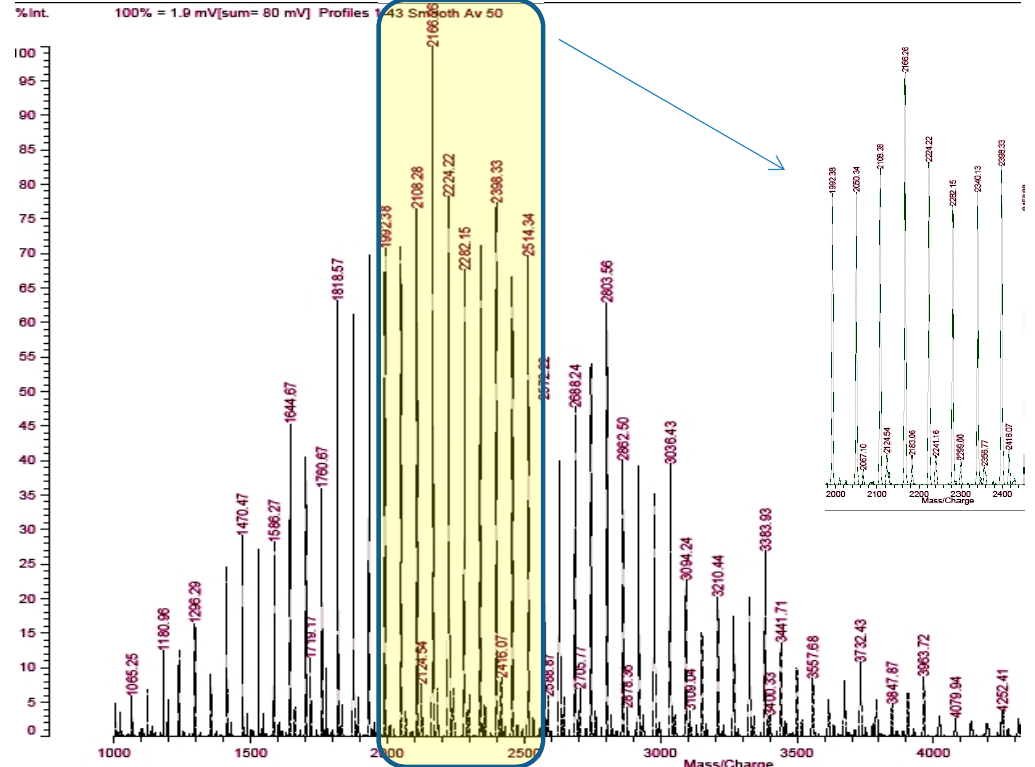
Figure 3. The MALDI-ToF analysis of obtained star-shaped structure on the cyclic macro-initiator with 6 alkoxide active centers. Table 1. The correlation between the theoretical and calculated masses from the MALDI-ToF spectra macromolecules.